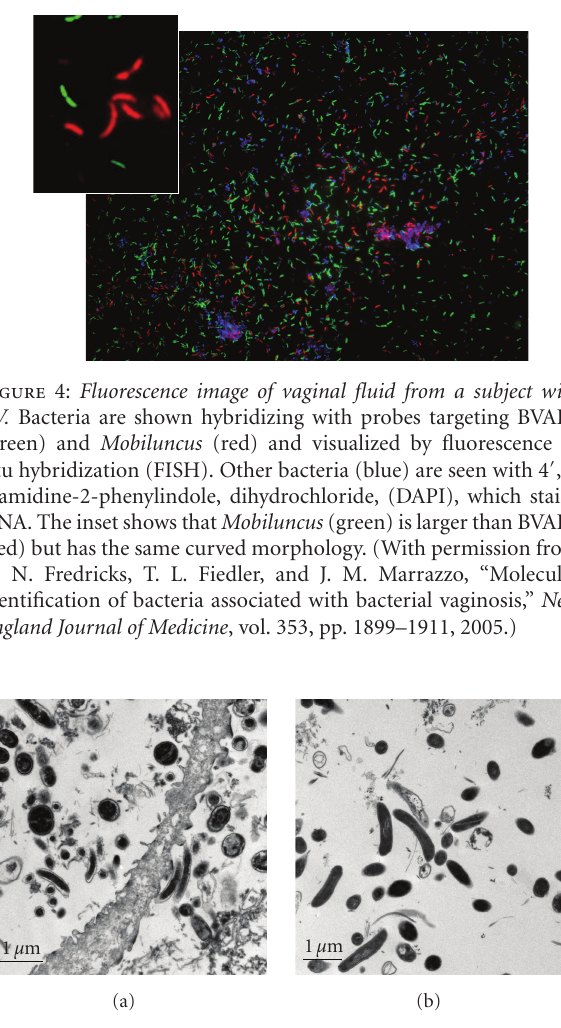
Figure 5: Transmission electron micrographs. (a) Electron micro- graph of vaginal fluid from a woman with bacterial vaginosis and high concentrations of bacterial vaginosis associated bacterium 1 (BVAB1) shows many curved rods with an electron translucent zone at the outer edge of the cell. (b) These cells are di ff erent from the larger, wider, and more electron dense curved rods observed in a pure culture of Mobiluncus curtisii . Both images are at 20000x